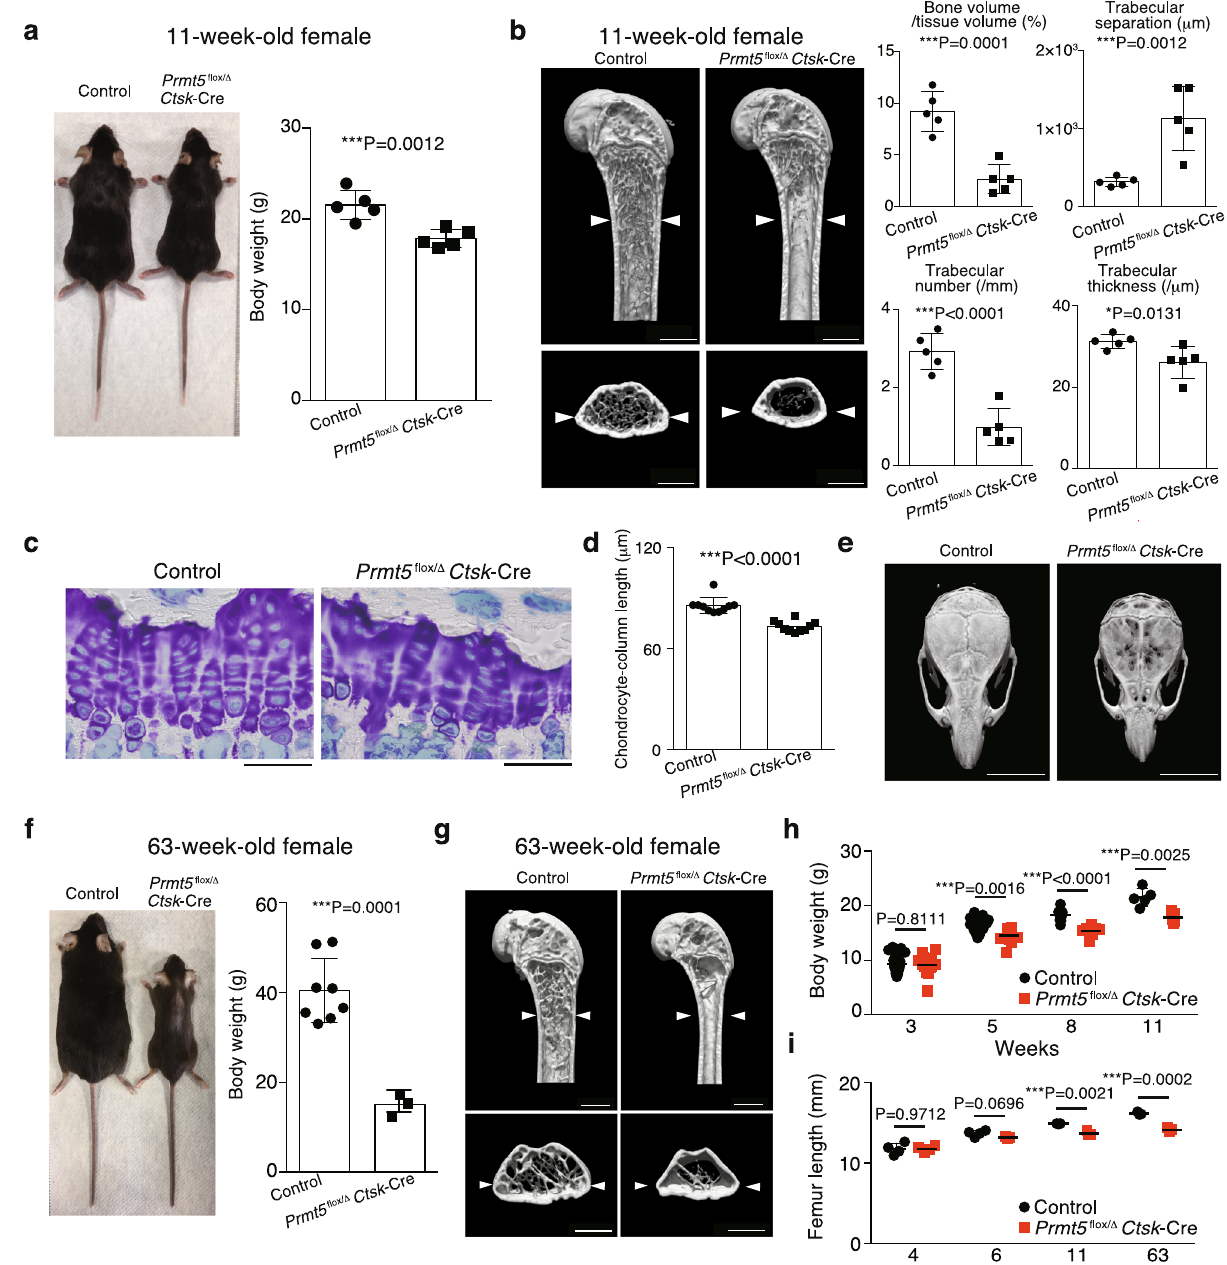
Fig. 1 Impaired bone growth in Prmt5 fl ox/ Δ Ctsk -Cre mice. a Macroscopic image and body weight of Prmt5 fl ox/ + Ctsk -Cre and Prmt5 fl ox/ Δ Ctsk -Cre mice ( n = 5 mice per group). P value was calculated using one-sided Student ’ s t -test. Data are presented as the mean±S.D. b Representative μ CT images and parameters of the femur in Prmt5 fl ox/ + Ctsk -Cre and Prmt5 fl ox/ Δ Ctsk -Cre mice (n = 5 mice per group). The white arrow heads indicate bone width in the control mice. Scale bars, 1mm. P value was calculated using one-sided Student ’ s t -test. Data are presented as the mean±S.D. c Toluidine blue staining of the growth plates in the proximal tibiae of 11-week-old female Prmt5 fl ox/ + Ctsk -Cre and Prmt5 fl ox/ Δ Ctsk -Cre mice. Representative pictures of more than three independent experiments are shown. Scale bars, 50 μ m. d Chondrocyte-column length in the growth plates in the proximal tibiae of 11-week-old female Prmt5 fl ox/ + Ctsk -Cre and Prmt5 fl ox/ Δ Ctsk -Cre mice ( n = 10 mice per group). P value was calculated using one-sided Student ’ s t -test. Data are presented as the mean±S.D. e Representative μ CT images of the skull of more than three littermates at the age of 11 weeks. Scale bars, 7mm. f Macroscopic image and body weight of female control and Prmt5 fl ox/ Δ Ctsk -Cre ( n = 8 and 3 mice per group) mice at 63 weeks of age. Prmt5 fl ox/ + , Prmt5 fl ox/ Δ , and Prmt5 fl ox/ + Ctsk -Cre mice were phenotypically identical, and so were grouped together and used as controls in ( f – i ). P value was calculated using one-sided Student ’ s t -test. Data are presented as the mean±S.D. g Representative μ CT images of the femur of male littermates at 63 weeks of age. Representative pictures of more than three independent experiments are shown. The white arrow heads indicate bone width in the control mice. Scale bars, 1mm. h Body weight of female littermates at 3, 5, 8 and 11 weeks of age (3 weeks: n = 21 and 13, 5 weeks: n = 16 and 9, 8 weeks: n = 10 and 7, 11 weeks: n = 5 mice per group). P values were calculated using one-sided Student ’ s t -test. Data are presented as the mean±S.D. i Femur length in female littermates at 4, 6, 11 and 63 weeks of age (4 weeks: n = 4, 6 weeks: n = 4 and 3, 11 weeks: n = 3, 63 weeks: n = 3 mice per group). P values were calculated using one-sided Student ’ s t -test. Data are presented as the mean±S.D. Source data are provided as a Source Data fi le.